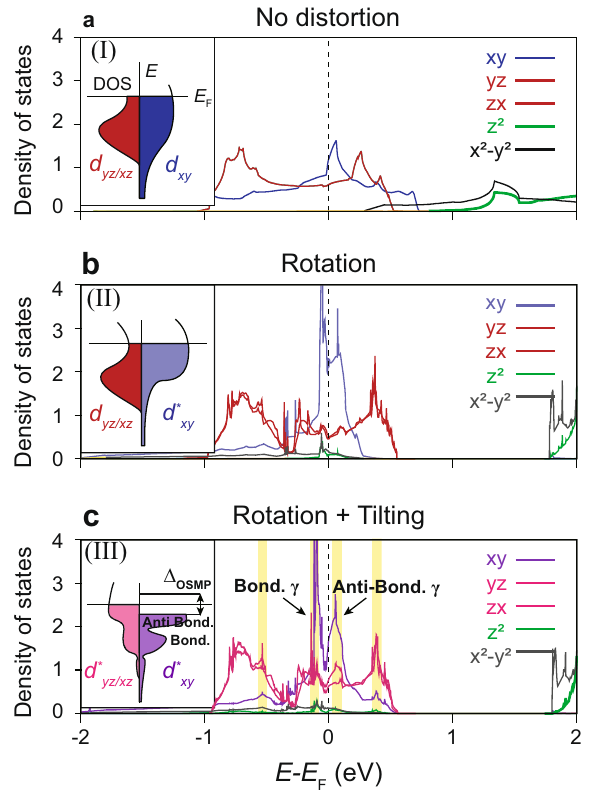
Fig. 4 Effect of octahedral distortions on the electronic structure of CSRO. Orbital-dependent (4 d ) density of states (DOS) at x = a 2.0, b 0.5, and c 0.2 from DFT calculations. Yellow shaded regions in c indicate the BE regions in which d xy and d yz/zx have a coincident DOS peak. Insets in a – c illustrate schematic electronic structure of octahedron distortion types (I – III).